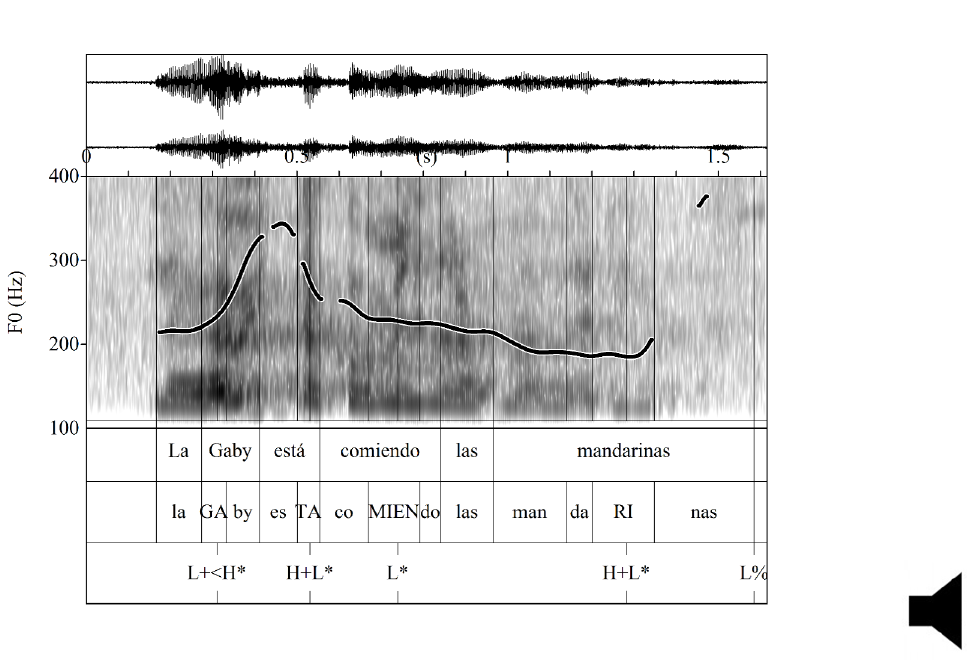
Figure 2 (Participant 12): Waveform and F0 trace for the broad focus statement La Gaby está comiendo mandarinas ‘Gaby is eating tangerines’ produced with L+<H*, H+L* and L* in pre-nuclear accents and H+L* nuclear accent followed by an L% boundary tone.